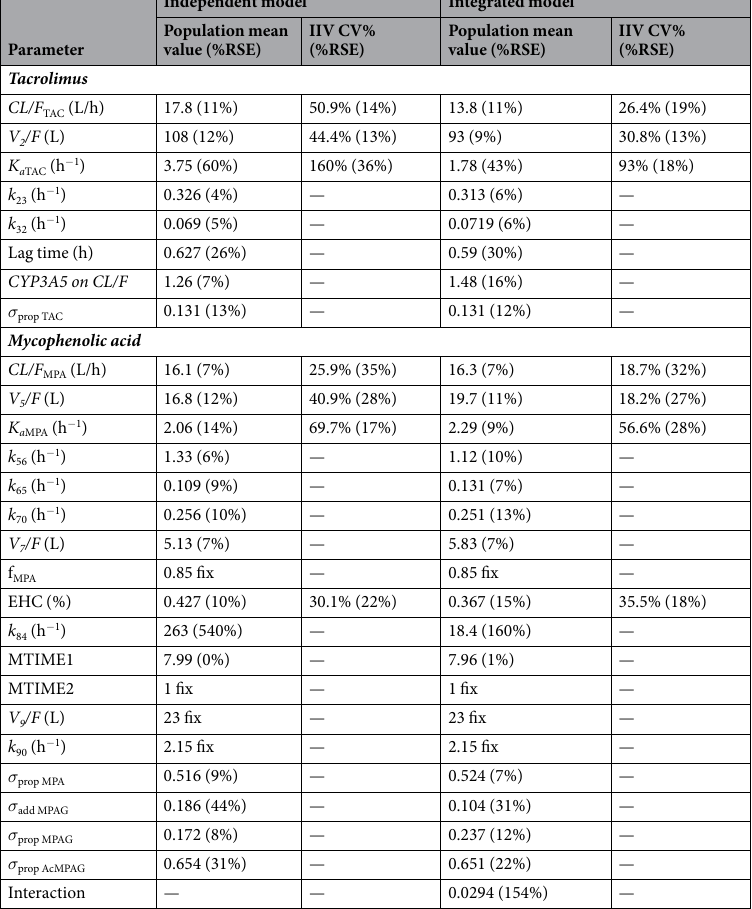
— Table 3. Population pharmacokinetic parameter estimates of models for TAC and MMF. IIV, interindividual variability; CV, coefficient of variation; RSE, relative standard error; F, fraction of the dose absorbed; CL/F , apparent clearance; TAC, tacrolimus; V/F , apparent volume of distribution; K a , first-order absorption rate constant; k 23 , k 32 , k 56 , and k 65 , intercompartment rate constants; MPA, mycophenolic acid; k 70 and k 90 , eliminated rate constants; CYP3A5 , CYP3A5 expressers ( CYP3A5 * 1/ * 1 or CYP3A5 * 1/ * 3); f MPA , fraction of MPA which metabolized to MPAG; EHC, enterohepatic circulation; k 84 , gallbladder emptying rate constant; MTIME1, meal time; MTIME2, Gallbladder emptying duration; MPAG, MPA 7-O-glucuronide; AcMPAG, MPA acyl glucuronide; σ prop, proportional residual error; σ add, additive residual